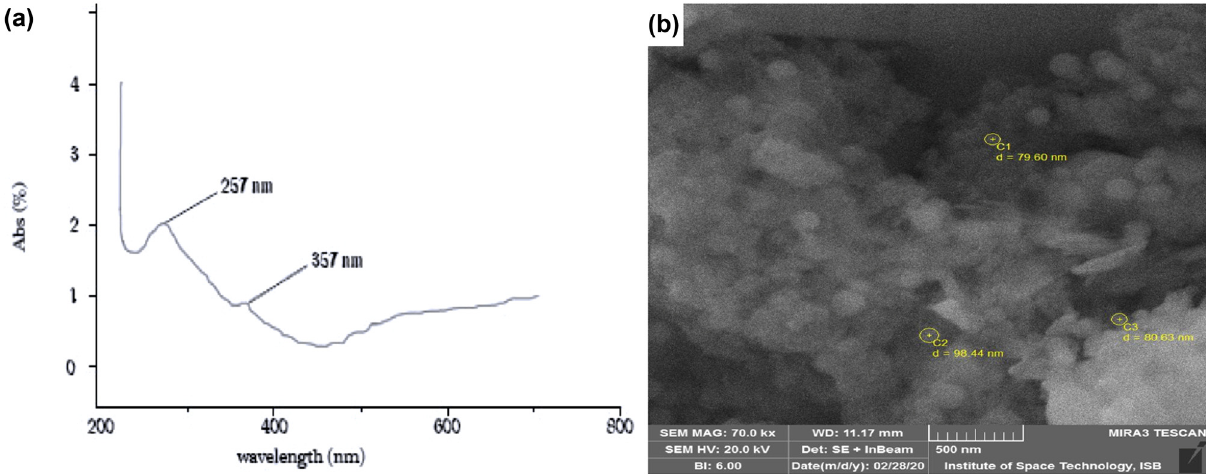
Figure 2: ( a ) UV - Visible spectrum showing the characteristic SPR band at 257 nm con fi rming the synthesis of SeNPs and ( b ) SEM image is showing that nanoparticles are anisotropic and irregular in shape and have a size range of 50 – 150